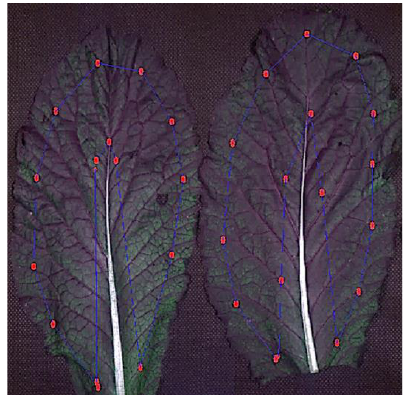
Figure 3. Extraction of the region of interest (ROI) by polygon selection. Table 2. Pre-processing combinations tested in this study.